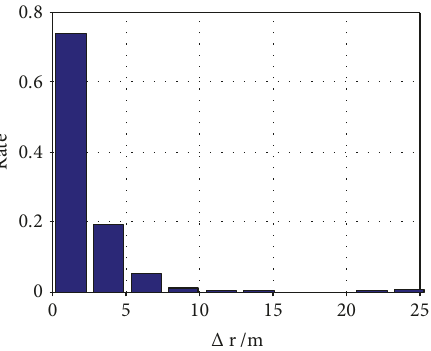
Figure 17: Distribution of dropping error.